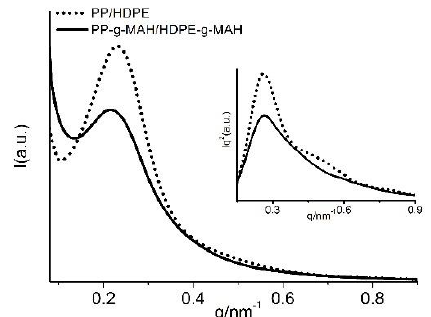
( b ) Figure 5. DSC thermograms of PP/HDPE blend and PP- g -MAH/HDPE- g -MAH blend at different cooling and subsequent heating rates: ( a ) 10 °C /min; ( b ) 2°C /min. SAXS study was also conducted for the two blends. As shown in Figure 6, since the two components in PP/HDPE blend are semi-crystalline polymers at room temperature, the SAXS scattering peak is contributed by both PP and HDPE lamellar stacks. It can be seen from the plots with linear intensity in Figure 6 that a much worse scattering peak is observed for the grafted blend, suggesting the lamellar packing in the grafted blend is not as good as in the corresponding un-grafted